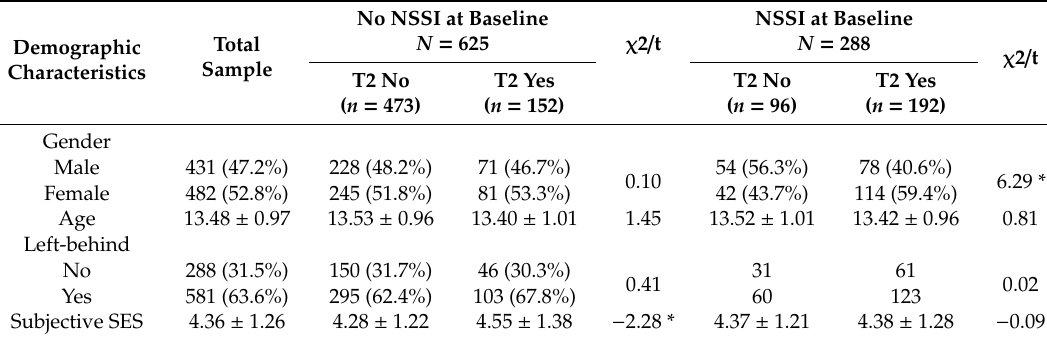
Table 1. Demographic characteristics for the study samples.